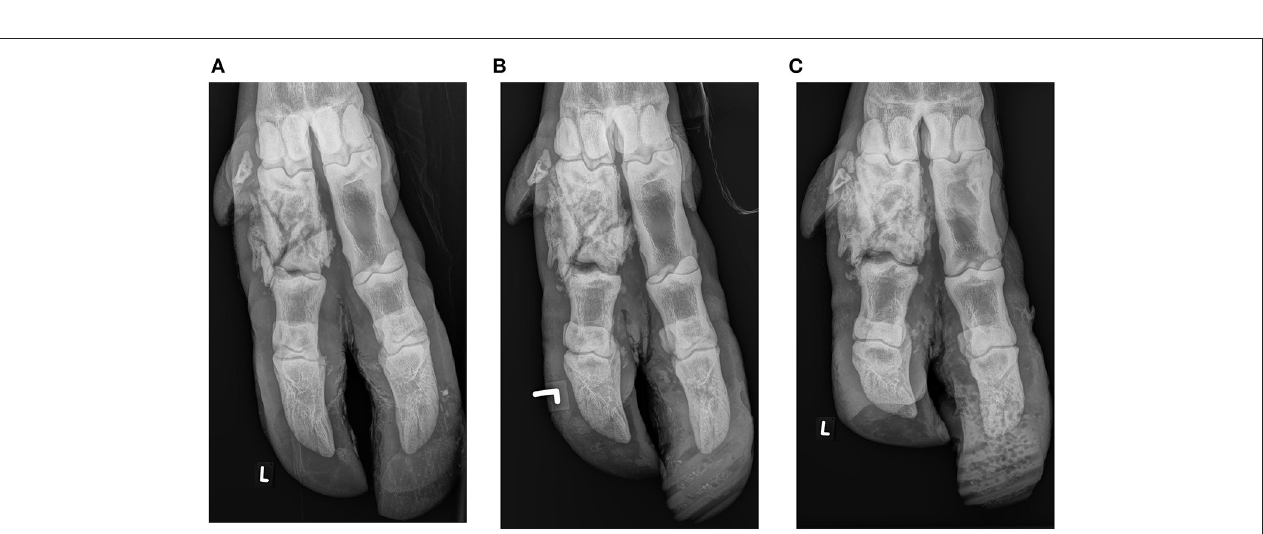
FIGURE 2 | Plantarodorsal radiographs of a multifragmentary fracture of the lateral proximal phalanx in an adult female European bison ( Bison bonasus ): Six (A) , 9 (B) , and 11 weeks (C) after the injury. At the initital treatment, a wooden claw block was used and polyurethane blocks thereafter.